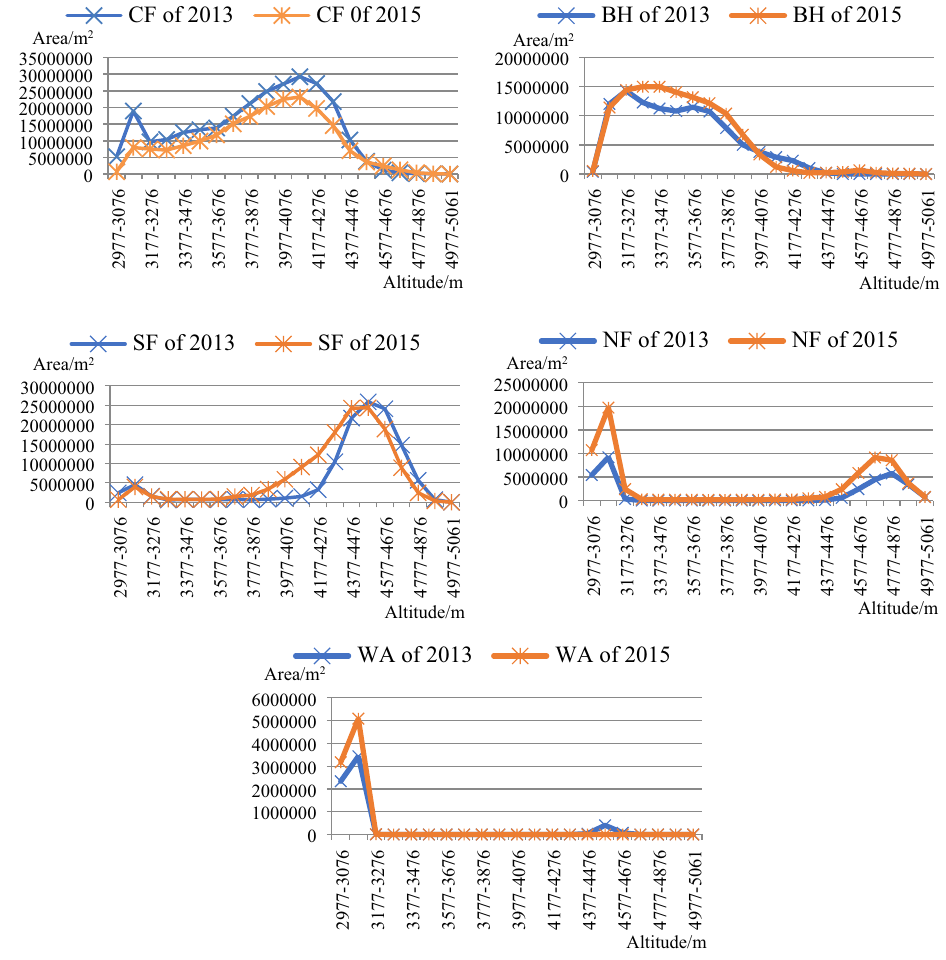
Figure 3. Distribution of the different land cover types in the 21 altitude gradients in 2013 and 2015. The figure is generated using the Microsoft Office 2016 (http:// www. office. com).